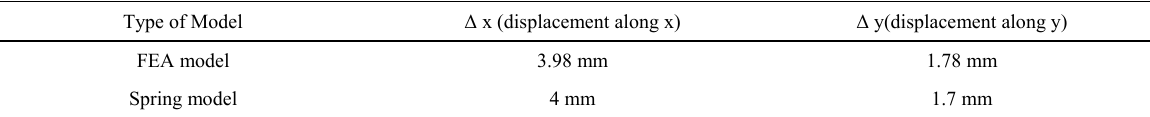
Table 5: comparison between lateral and transversal joint displacement calculated by FEA or using the spring